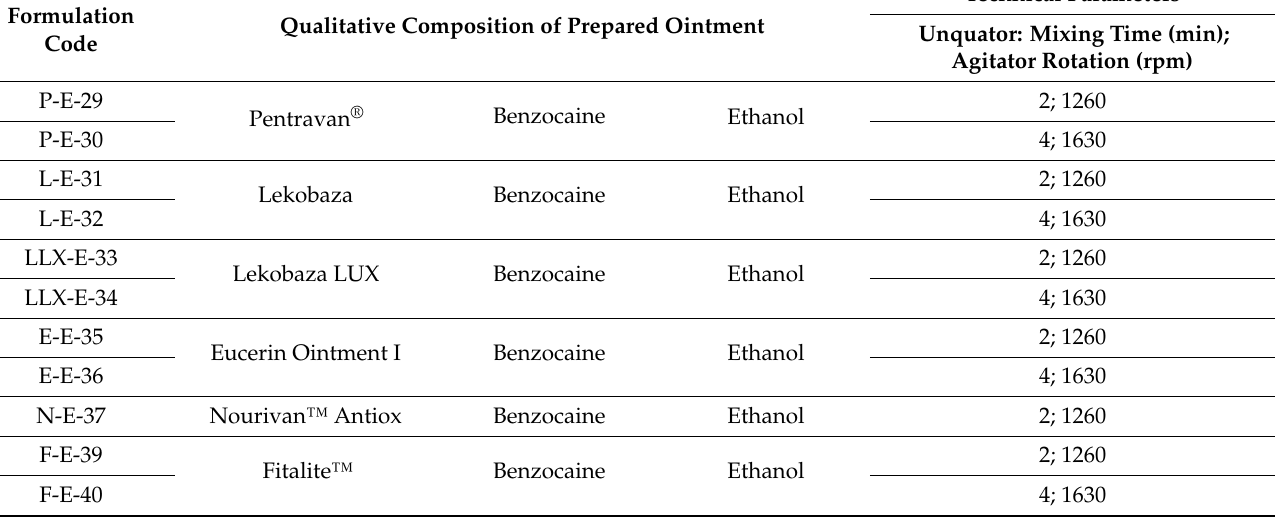
Table 2. The composition of emulsion ointments with benzocaine and technical parameters of their formulation